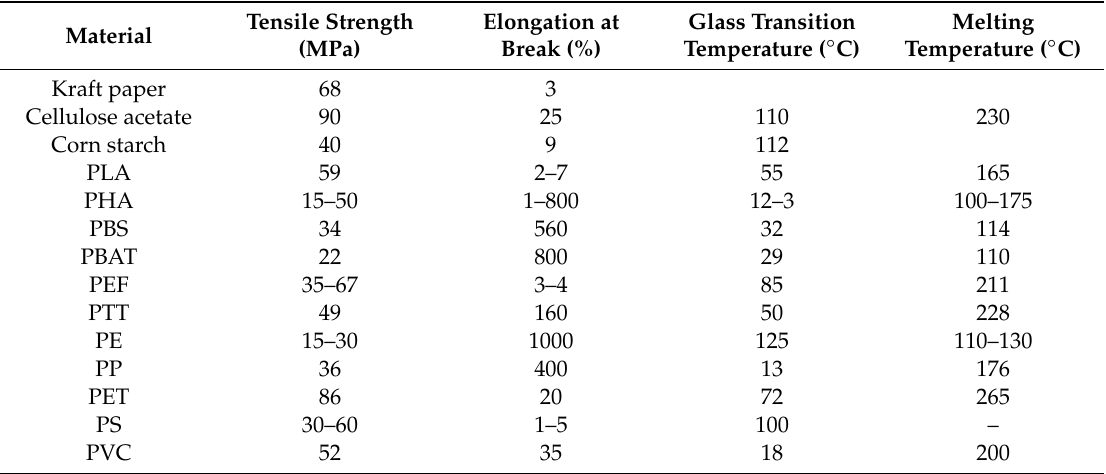
Table 4. Comparative analysis of the mechanical properties of plant-based and petro-chemical based polymers